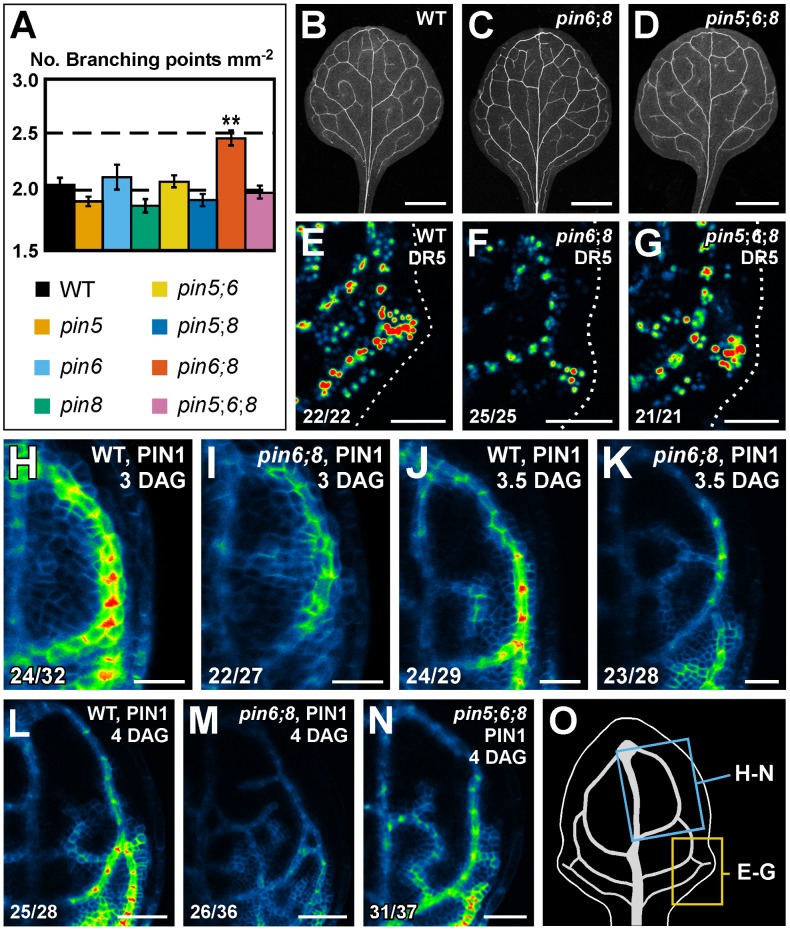
Necessity of PIN5, PIN6, and PIN8 for vein network formation.(A) Vein network complexity as mean ± SE number of vein branching points per first-leaf area unit in mm2
[28]. Difference between pin6;8 and all other genotypes was significant at P<0.01 (**) by one-way ANOVA and Tukey's test. Sample population sizes: WT, 30; pin5, 30; pin6, 30; pin8, 27; pin5;6, 28; pin5;8, 28; pin6;8, 28; pin5;6;8, 28. (B–N) Top right: genotype, markers and leaf age in days after germination (DAG). Bottom left: reproducibility index. (B–D) Dark-field illumination of cleared mature first leaves. (E–N) Confocal laser scanning microscopy; first leaves. LUT (in Figure 2K) visualizes expression levels. (E–G) DR5rev::YFPnuc expression, 4 DAG. Dotted line: leaf outline. (H–N) PIN1::PIN1:YFP expression. (O) 4-DAG first leaf illustrating positions of close-ups in (E–G) and (H–N). Bars: (B–D) 1.5 mm; (E–G,L–N) 50 µm; (H–K) 25 µm.